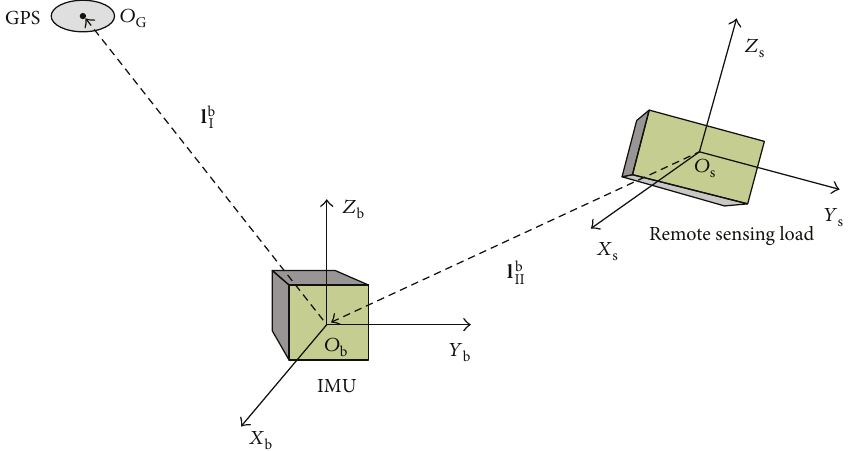
Figure 1: The multilevel rigid lever arm